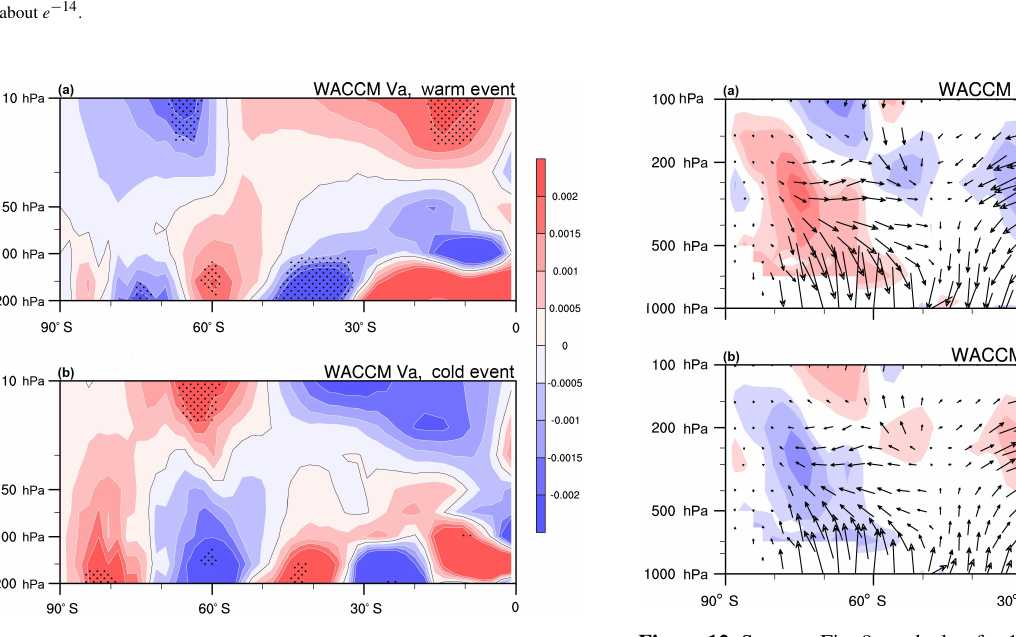
Figure 12. Same as Fig. 9a and c but for 1000–100hPa.